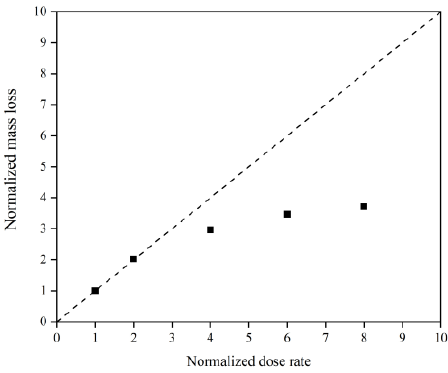
Figure 25. Mass loss of the Kapton during atomic oxygen impact at different dose rates.